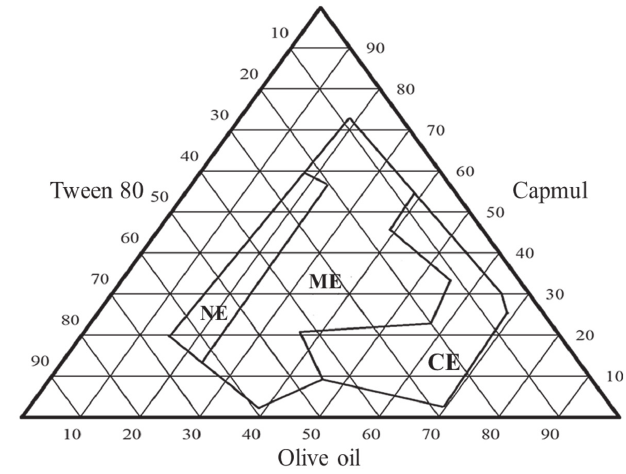
FIGURE 1 - Pseudo-ternary diagram for all the